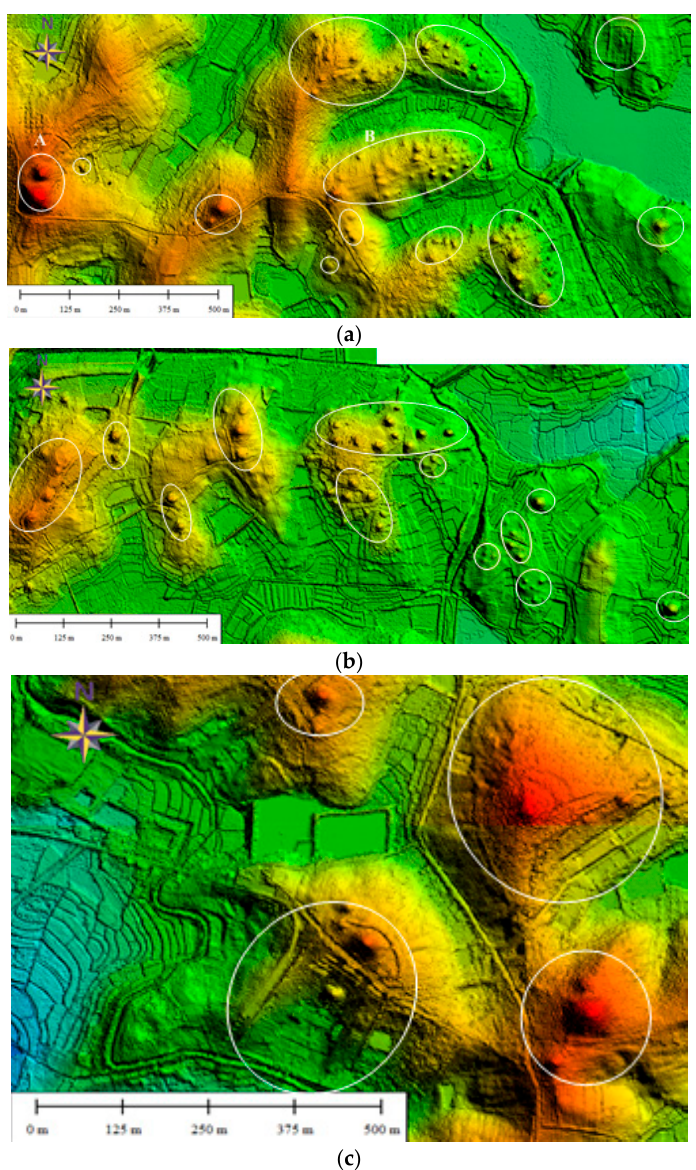
Figure 9. Spatial distribution of Chu tombs in the Balingshan District: ( a ) Chu tombs in Region 1; ( b ) Chu tombs in Region 2; and ( c ) Chu tombs in Region 3.